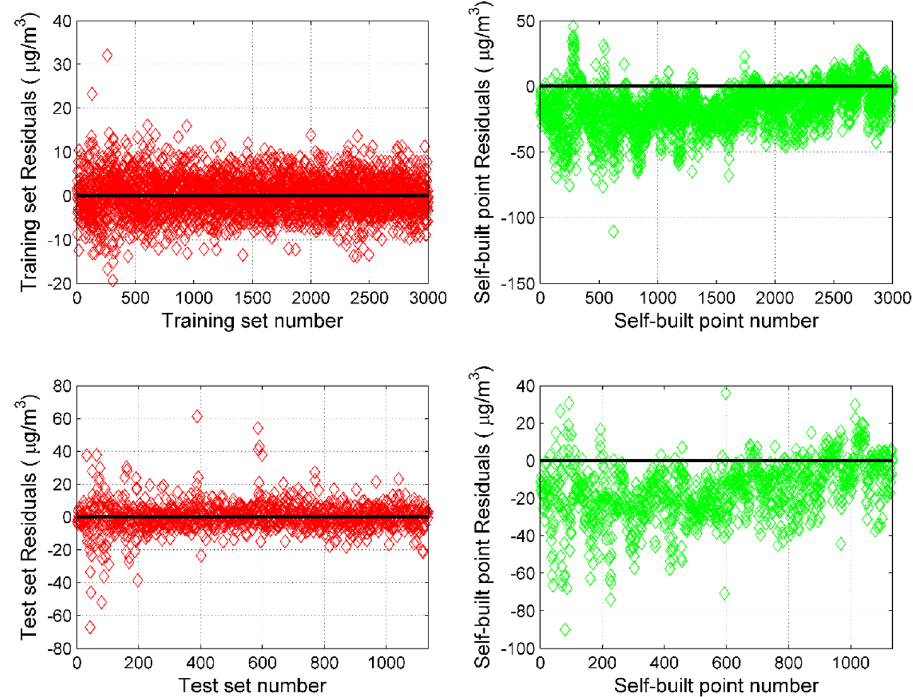
Figure 5. Comparison of PM 2.5 ’s PCA–RVM model residuals and self-built point residuals. The comparison of the training set is on the left, and the comparison of the test set is on the right.